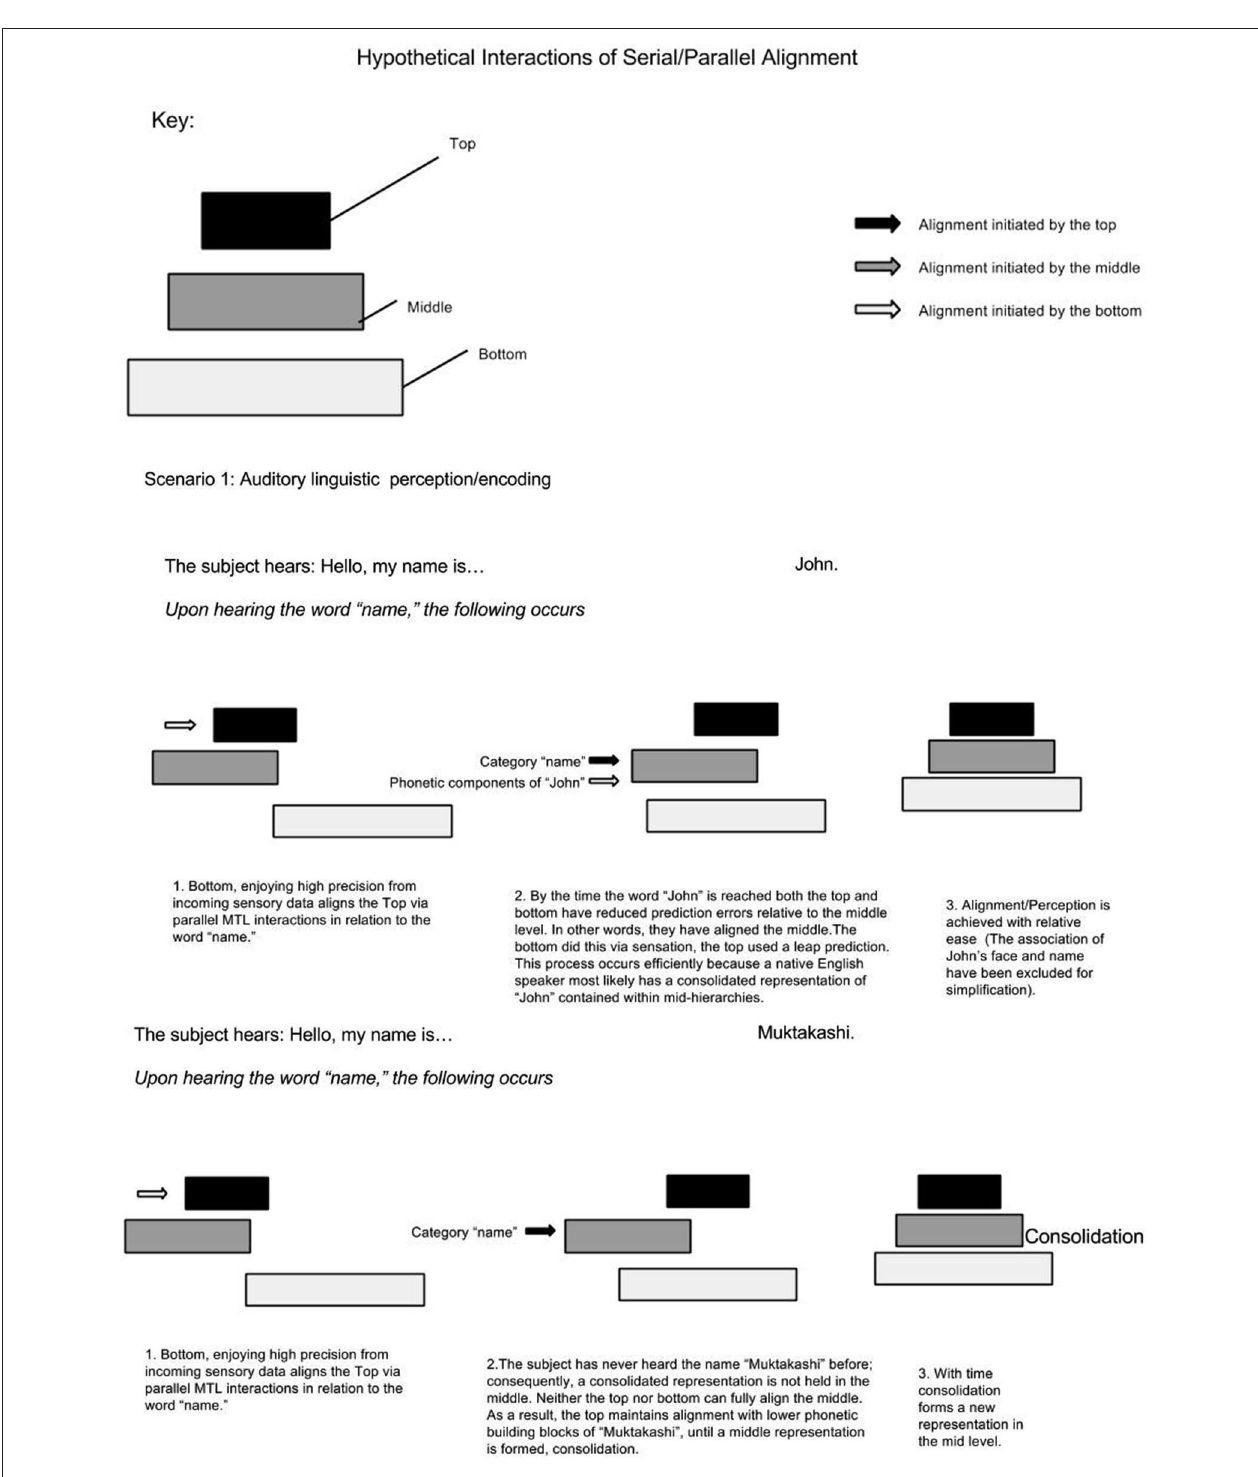
FIGURE 3 | Demonstrates alignment of consolidated vs. non-consolidated representations